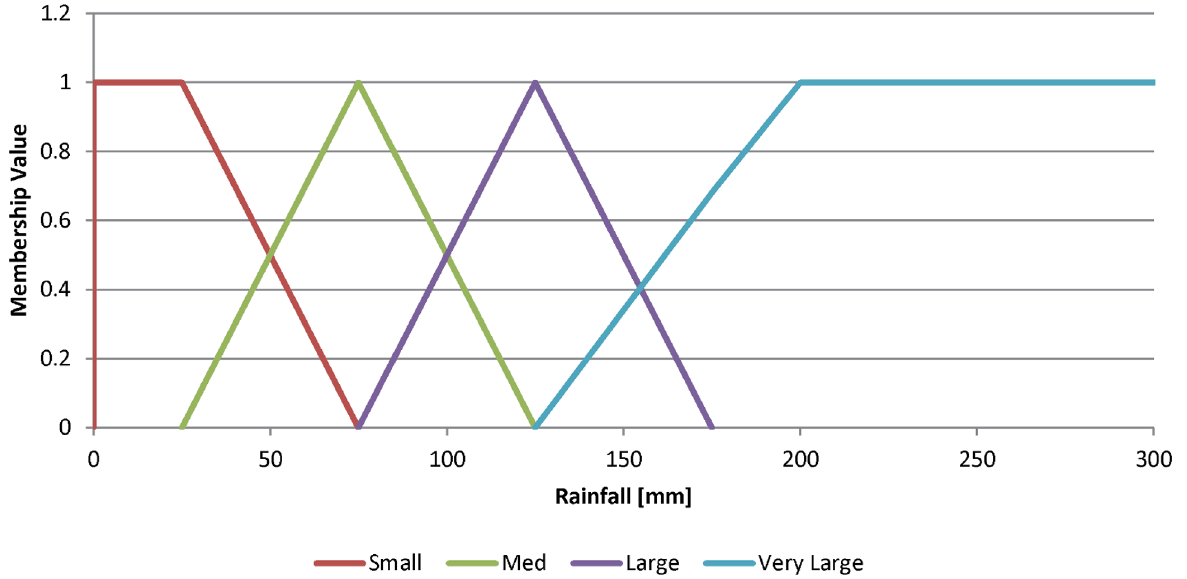
Figure 4. Membership functions for the variable Rainfall: SMALL , MED , LARGE , VERYLARGE .